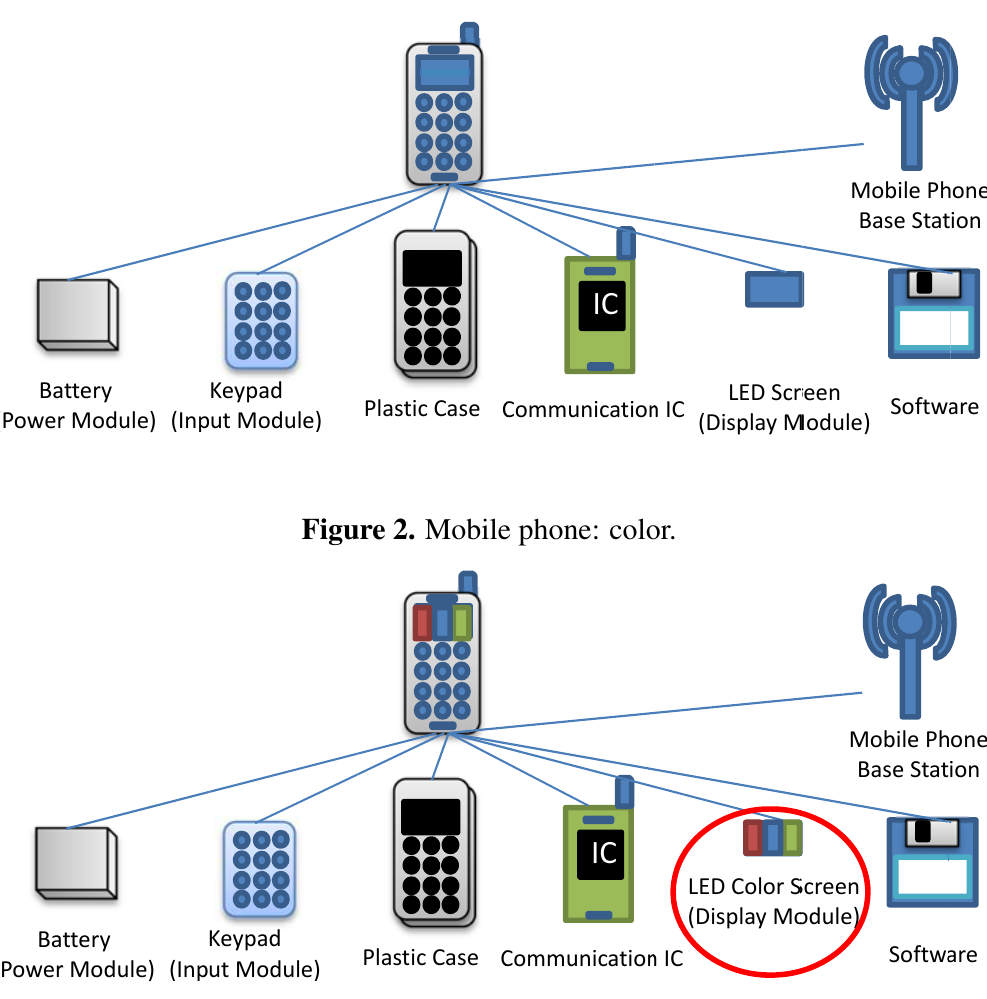
Figure 1. Mobile phone: black and white.